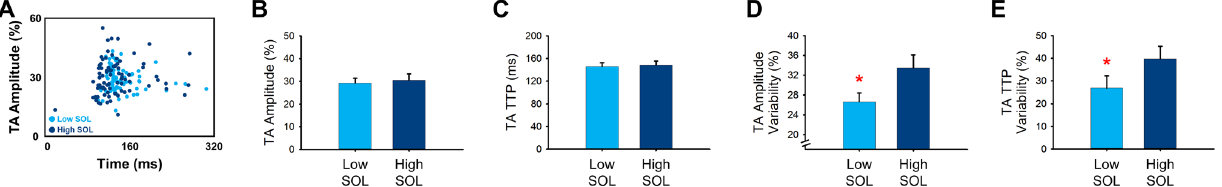
Figure 7. Muscle activity for the tibialis anterior and soleus muscles for young adults using a Low SOL and High SOL coordination pattern. Representative example of TA muscle activity ( A ) for young adults using a Low SOL and High SOL coordination pattern. Using a High SOL coordination pattern, young adults exhibited similar normalized TA amplitude ( B ) and TA time-to-peak (TTP; C ), but greater TA amplitude variability ( D ), and TA time-to-peak variability ( E ) relative to a Low SOL coordination pattern. *p < 0.05.